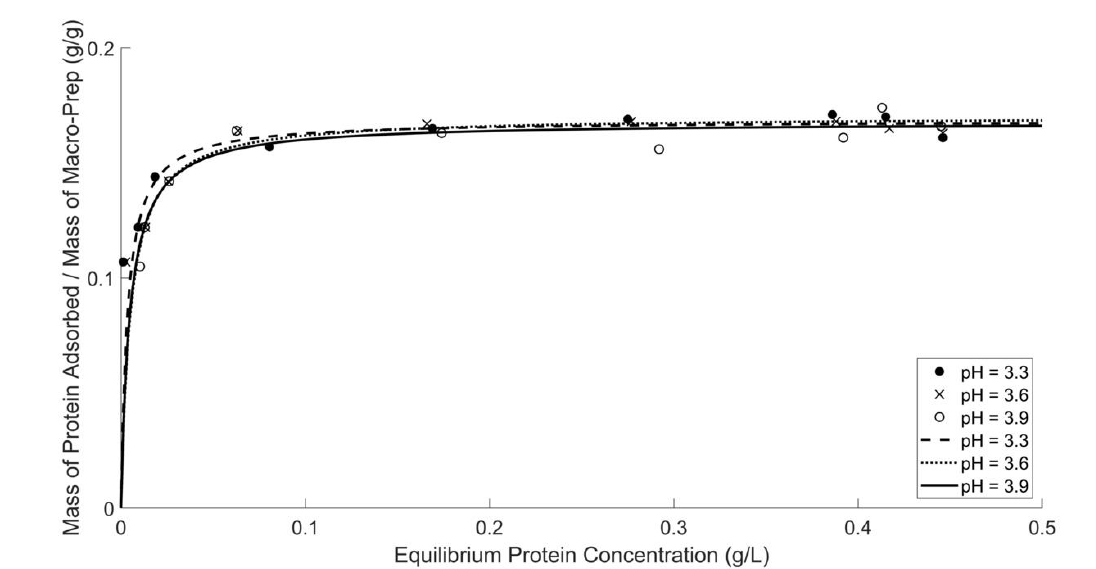
Figure 1. Protein adsorption by Macro-Prep ® in model wine solutions with different pH values. Protein concentration was measured by using the Bradford protein assay and a UV-Vis spectrometer at 595 nm.